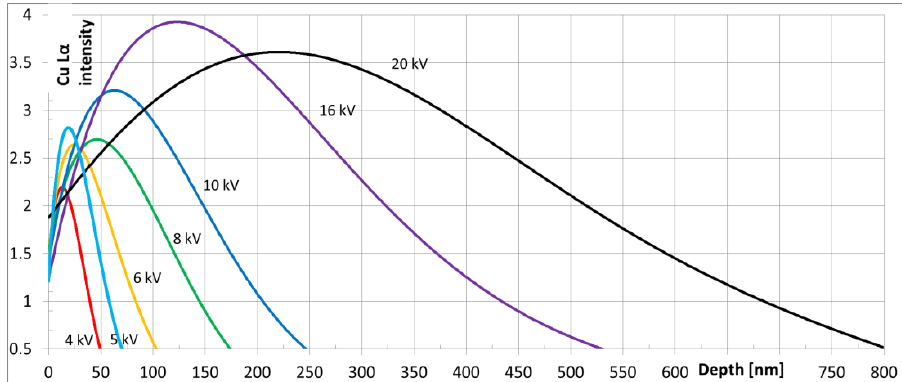
Figure 1. Results of calculation, showing depth of Lα X -ray emission of Cu.